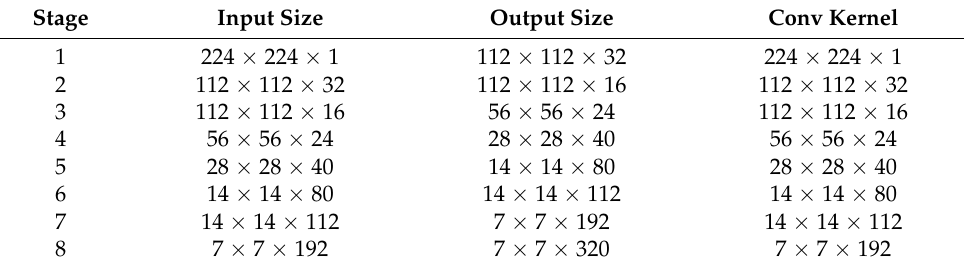
Table 2. Partial model parameters of two-dimensional convolution.